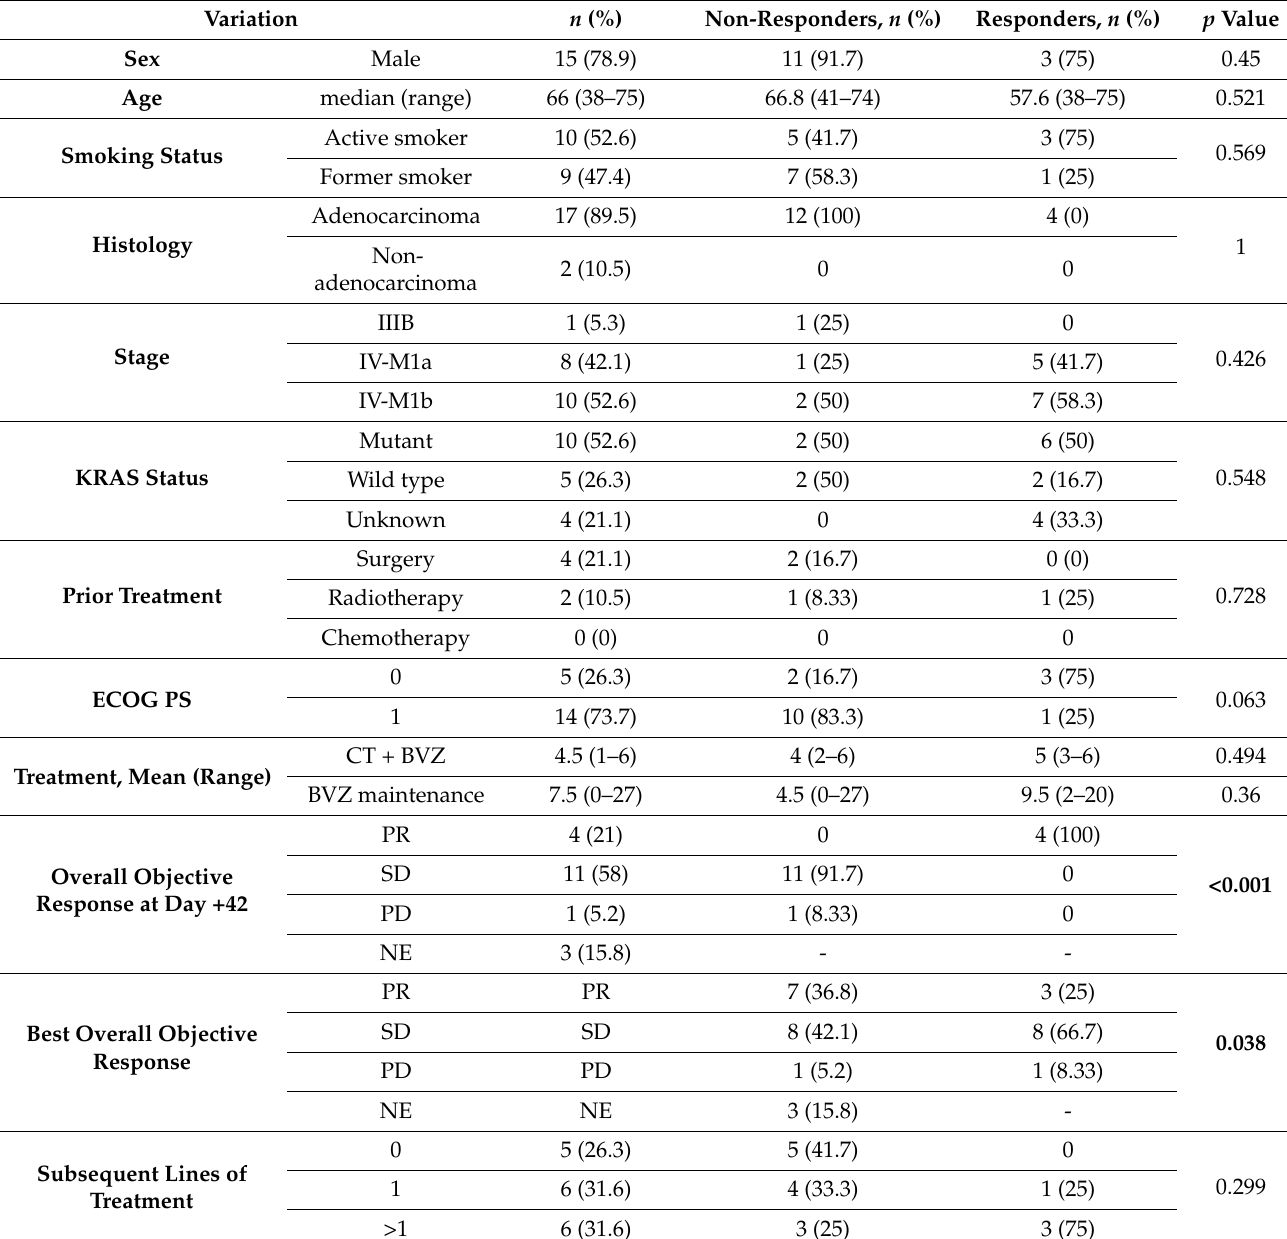
Table 1. Demographic and baseline characteristics of